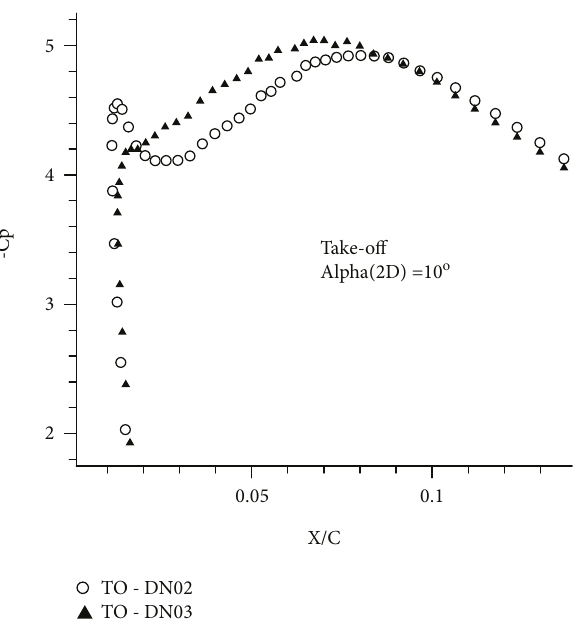
Figure 26: Computed pressure distributions for the two droop nose shapes at high angle of attack. Detail at wing leading